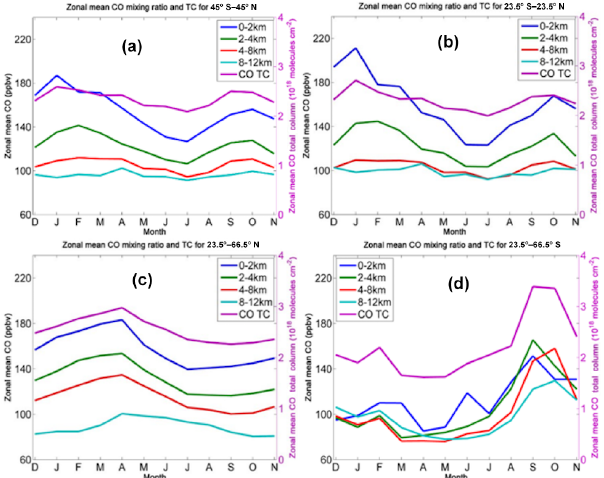
Figure 15. Zonally averaged monthly variation of CO for the lati- tude bands 45 ◦ S–45 ◦ N, 23.5 ◦ S–23.5 ◦ N, 23.5–66.5 ◦ N, and 23.5– 66.5 ◦ S, for the period 2001–2012. CO mixing ratios are shown for altitude ranges 0–2, 2–4, 4–8, and 8–12km, as well as total column (TC).